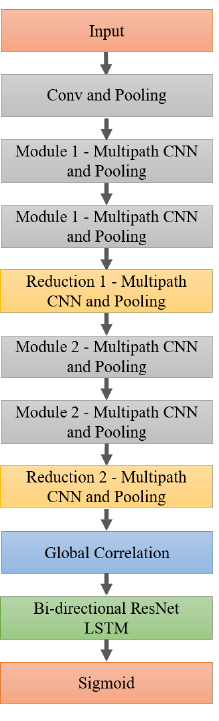
Figure 2. A modular depiction of the